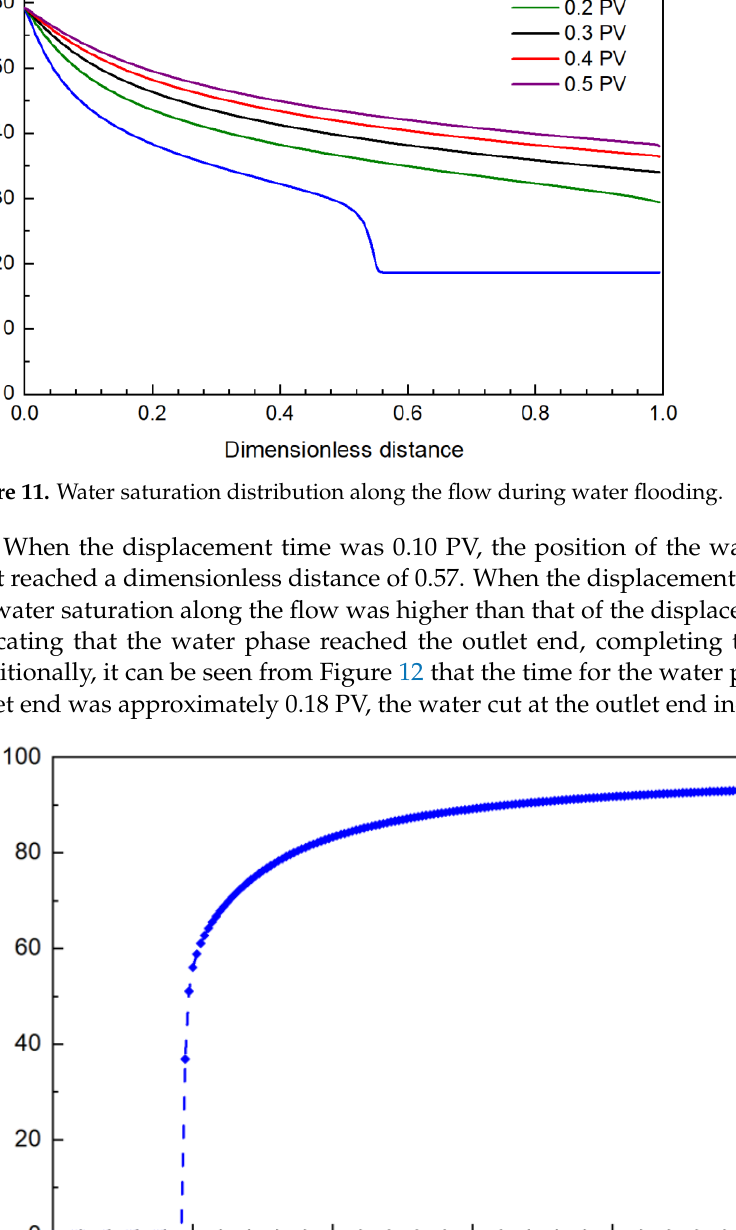
Figure 12. The water cut change at the outlet end.